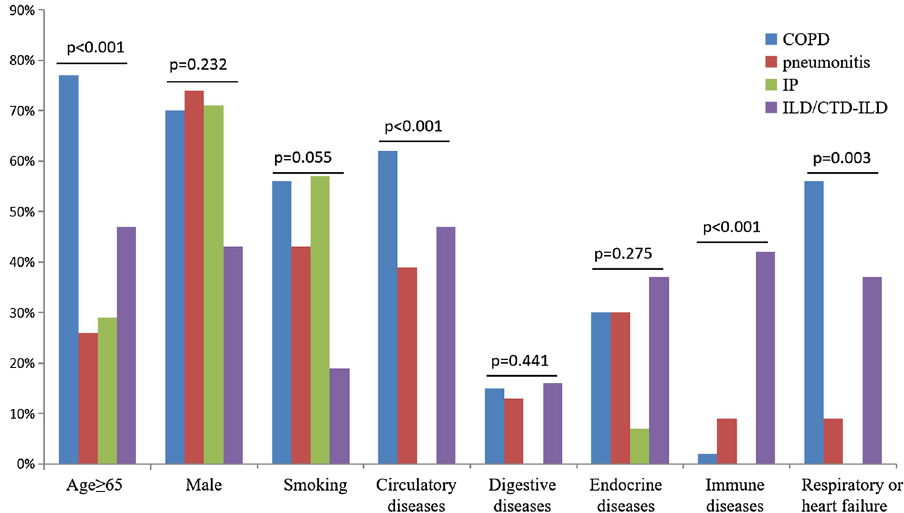
Figure 4. Characteristics of CEA elevations in four types of benign lung disease. COPD Chronic obstructive pulmonary disease, IP Inflammatory pseudotumor, CTD-ILD Connective tissue disease-associated interstitial lung disease, ILD Interstitial lung disease.